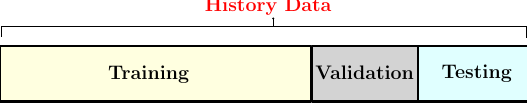
Figure 8. The specific category of the history